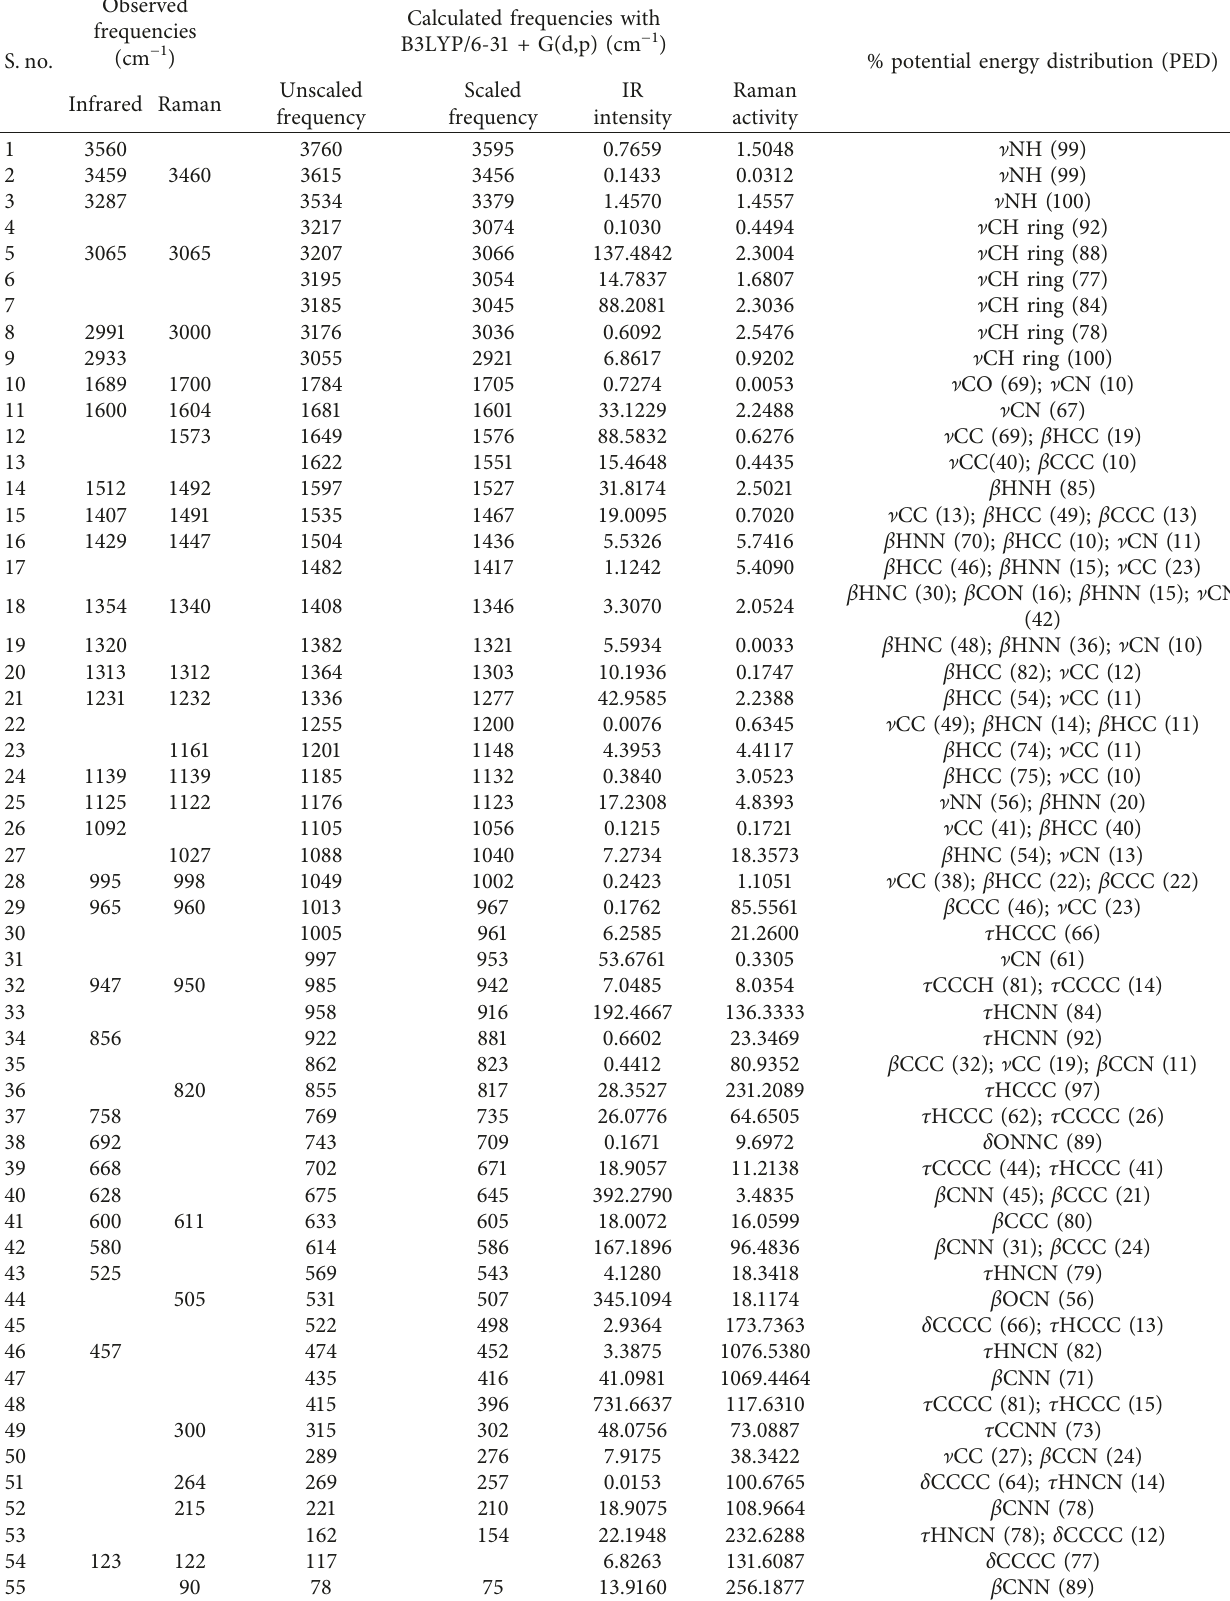
Table 5: Observed and calculated frequencies of